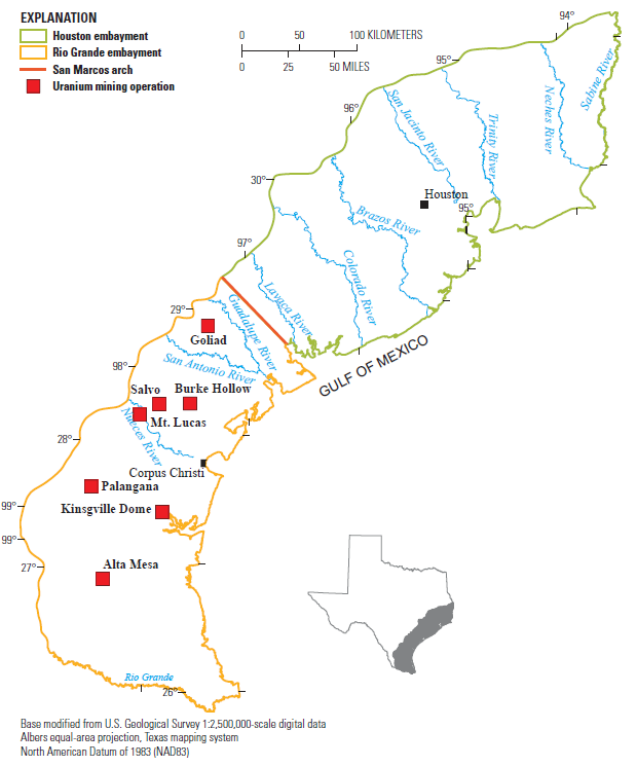
Figure 13. Uranium mining operations in permissive tract 3 within the Texas Coastal Plain.